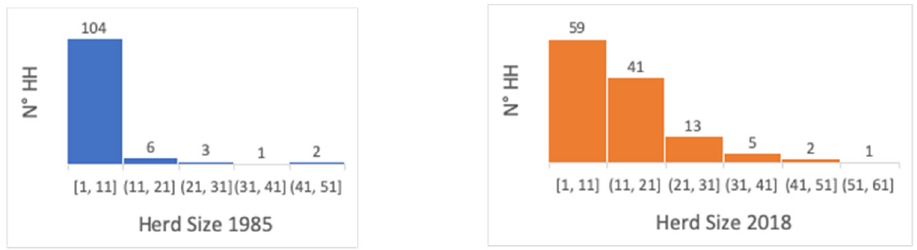
Figure 4. Herd Size 1985 and 2018.